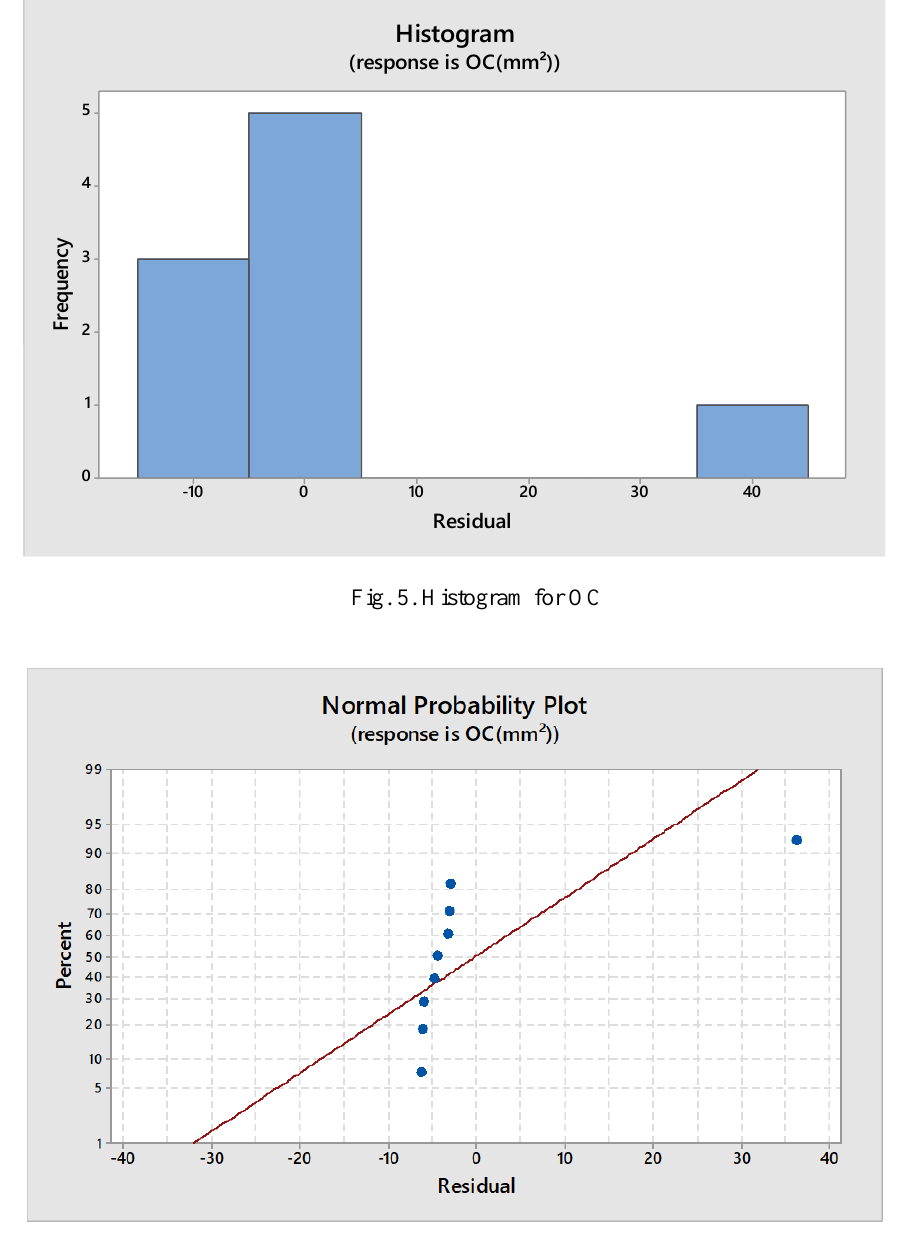
Fig. 6. Normal probability plot for